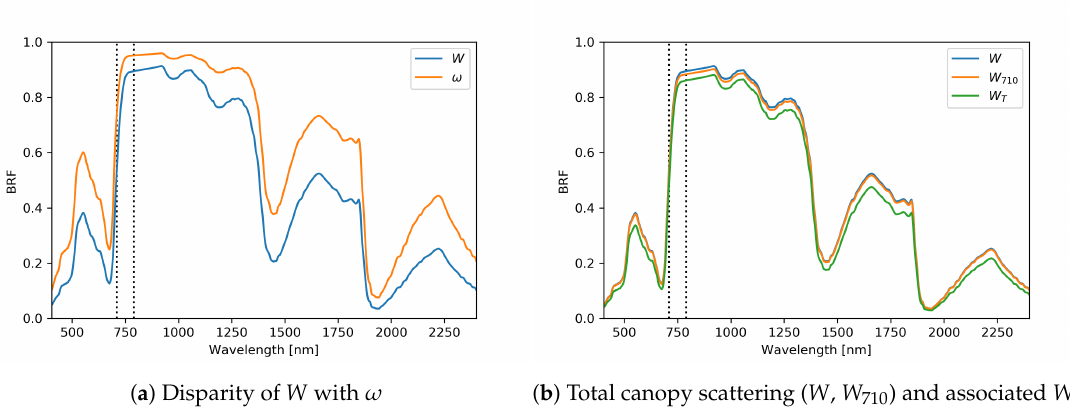
Figure 4. Comparison of W and ω , and prediction of total canopy scattering ( W and W 710 ) compared to W T , where dotted vertical lines represents 710–790 nm region used to compute W 710